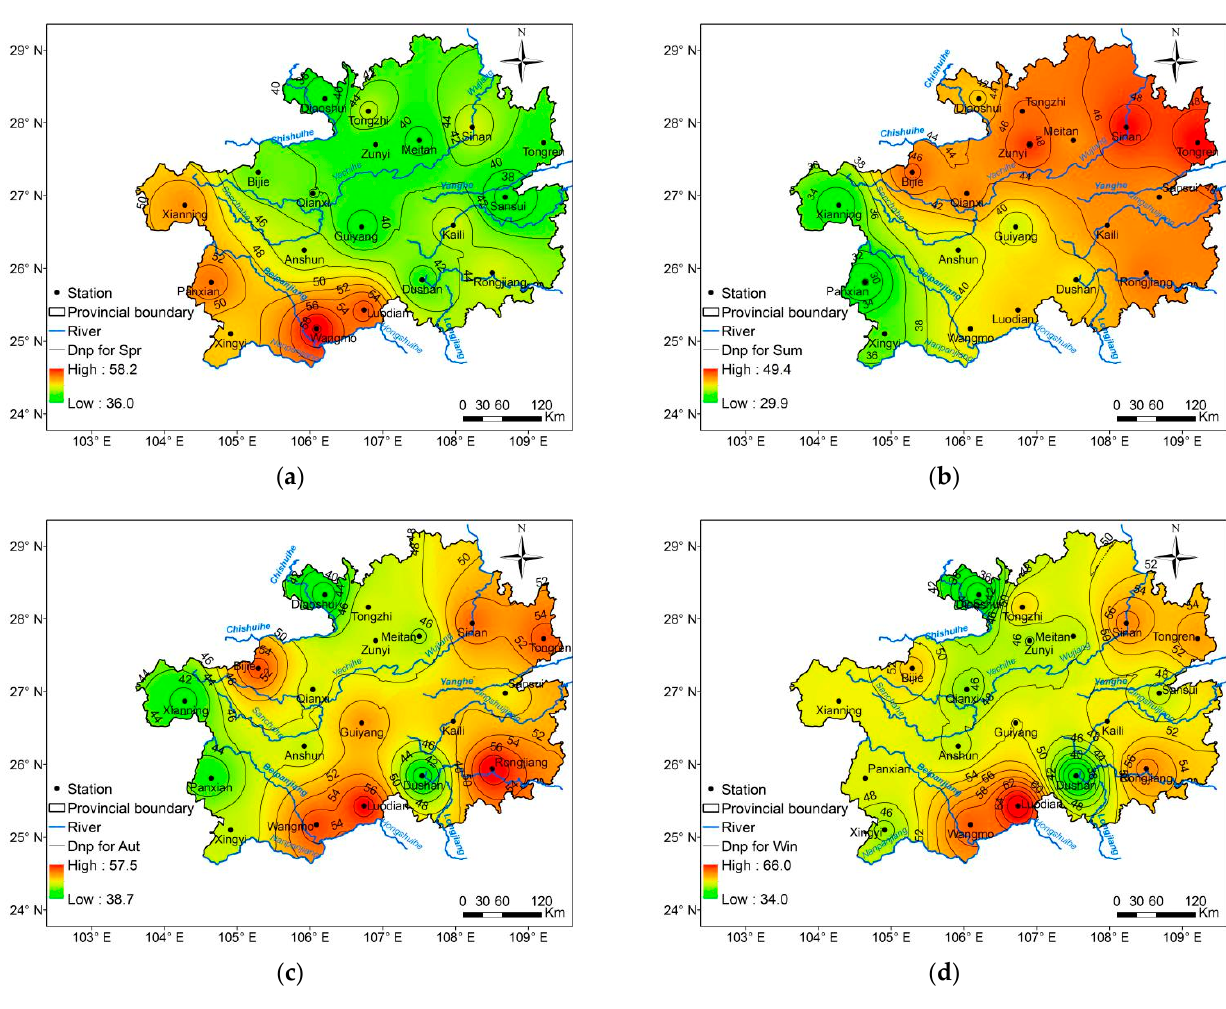
Figure 4. The temporal changes of seasonally average Dnp in ( a ) spring, ( b ) summer, ( c ) autumn, ( d ) winter. Table 2. Changes of seasonally mean Table 1. MK values for different classifications of Dnp.